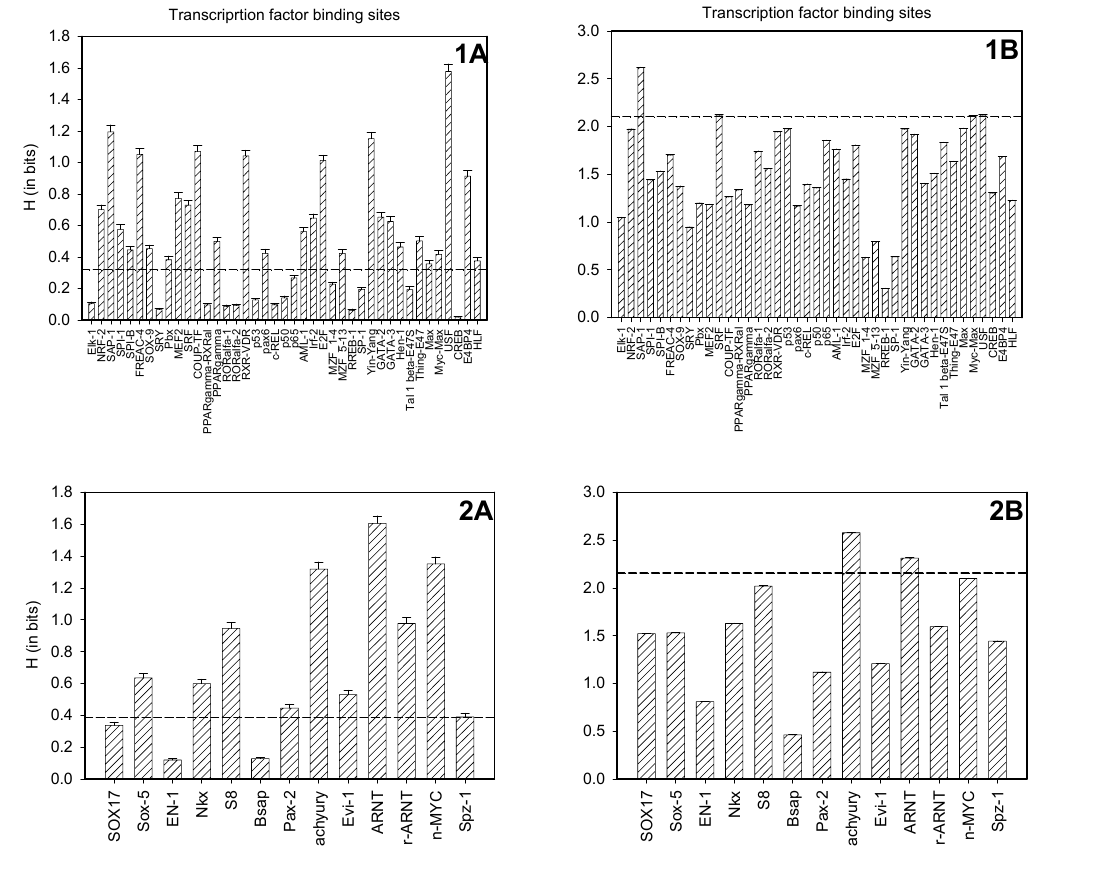
Figure 2: The average mutual information content H (in bits) of TFBS (calculated by (A; left) neighbor-independent and (B; right) neighbor-dependent nucleotide substitutions) of human (1A and 1B) and mouse (2A and 2B). The dotted line represents information content of random sequence of their genome. The bars of the histograms represent the standard errors of the 16 neighbor-independent substitution matrices. In case of neighbor dependent substitution H ij matrices, (256 H ) the error bars have been calculated as the standard errors of these 256 , ij kl elements. The standard errors have been actually plotted but cannot be seen, as they are too small in case of